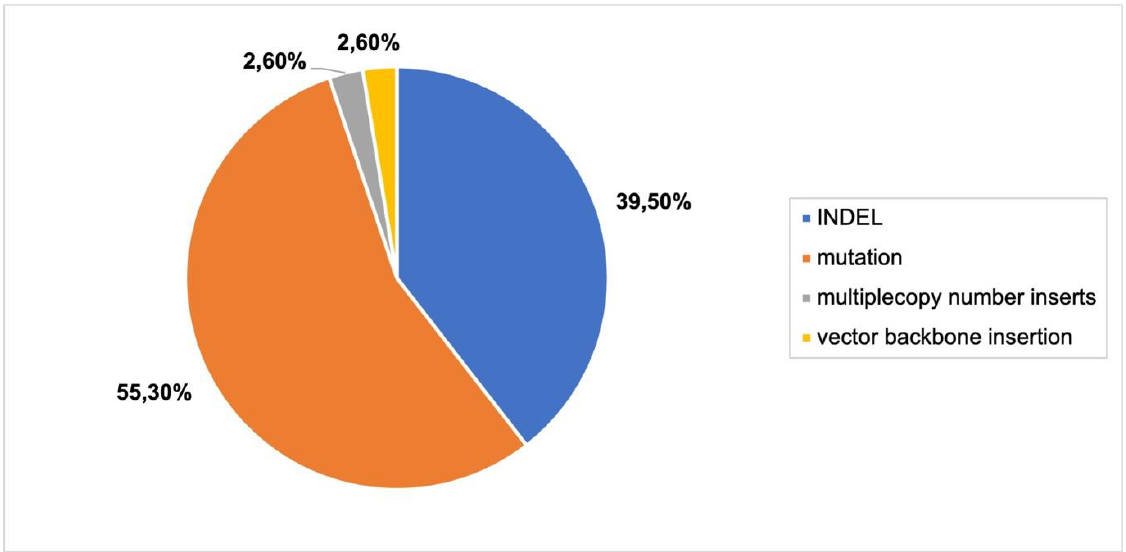
Figure 8. Genomic outcomes from CRISPR-Cas9 as RNPs. N = 8 articles. Colors in graph correspond to legend in Figure 4A. to legend in Figure